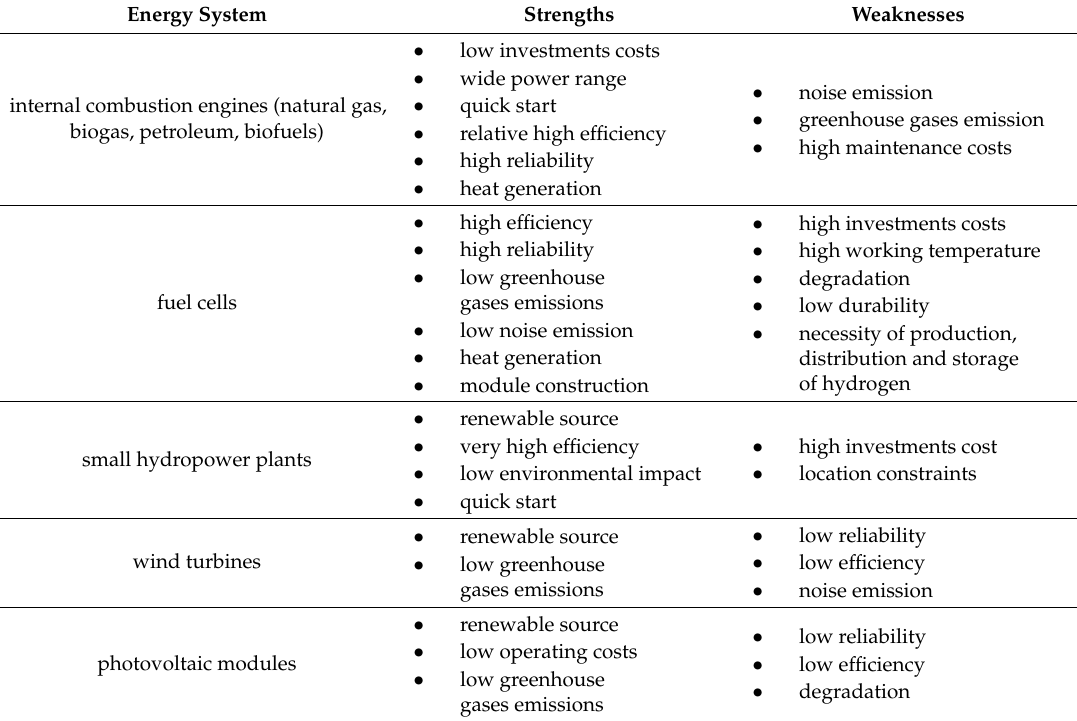
Table 1. Table of strength and weakness points of various energy